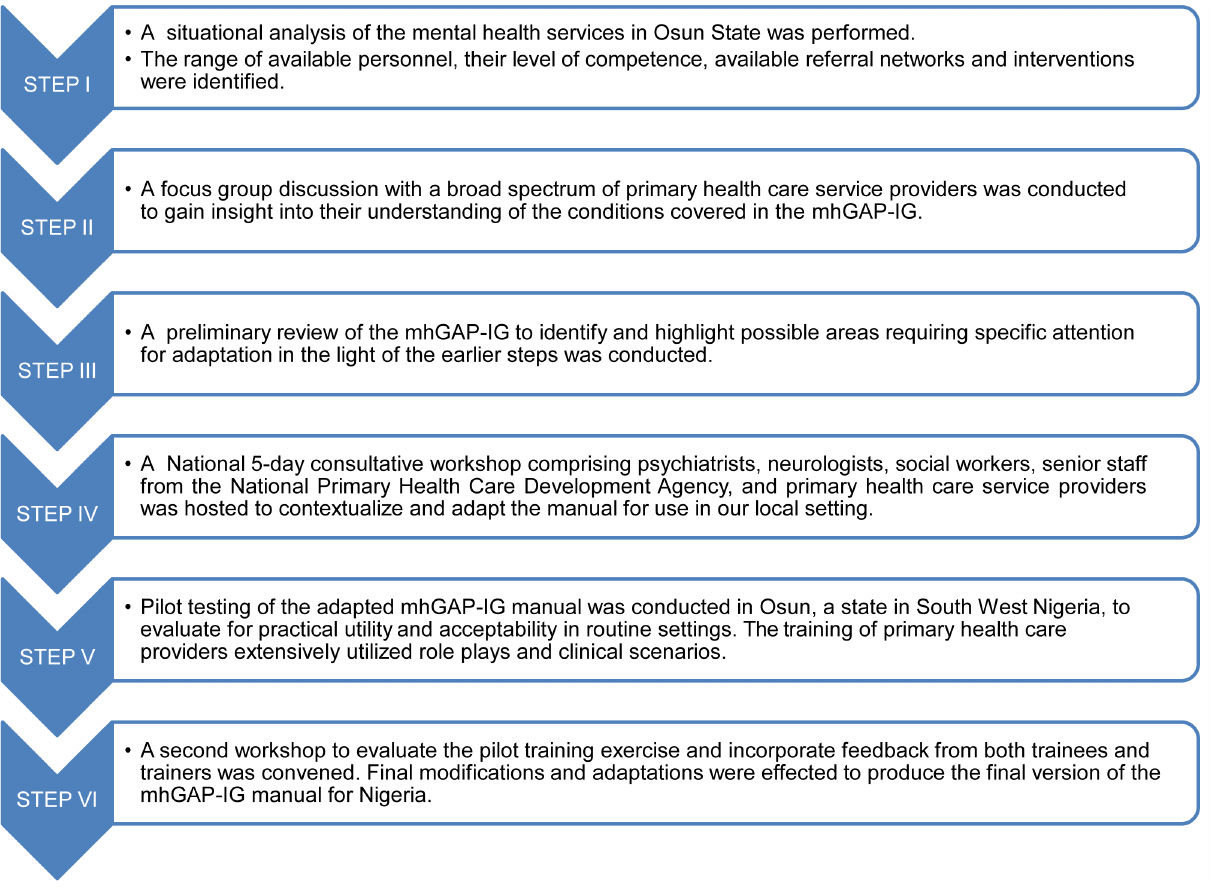
Figure 1. Flowchart describing the Mental Health Gap Action Programme – Intervention Guide contextualization process in Nigeria.